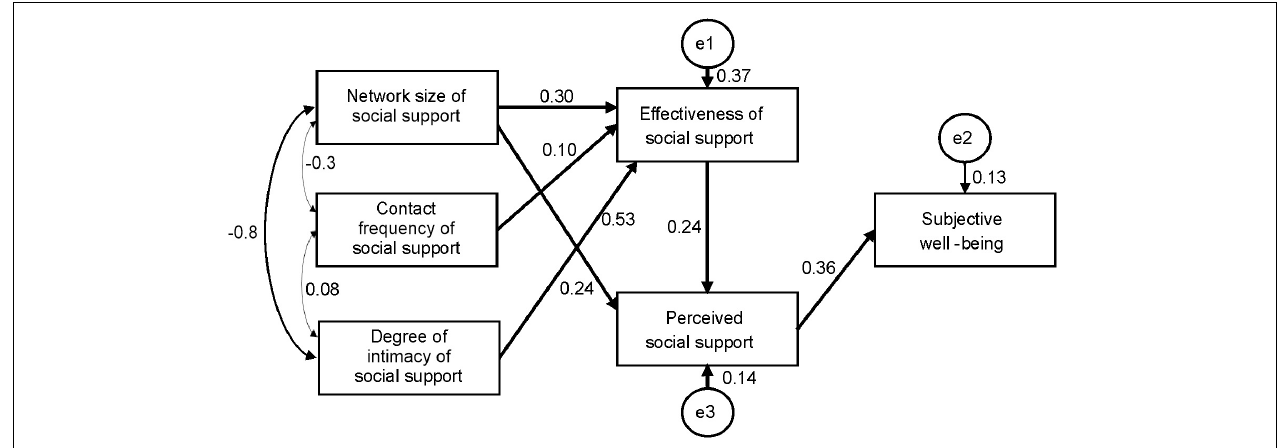
FIGURE 2 | Path analysis of the influence pattern of social support network on perceived social support and wellbeing. TABLE 6 | Correlation analysis between the characteristics of social support network sub-dimensions and perceived social support sub-dimensions. Guidance Social integration Attachment Reassurance of and reliable alliance